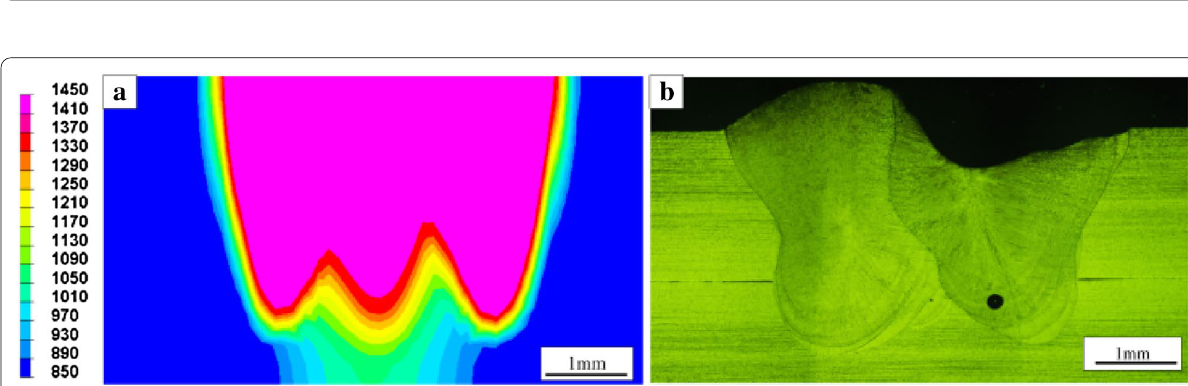
Figure 16 Welding method is 5-sections of joint morphology: a Numerical simulation of molten pool morphology; b Actual welded joint morphology